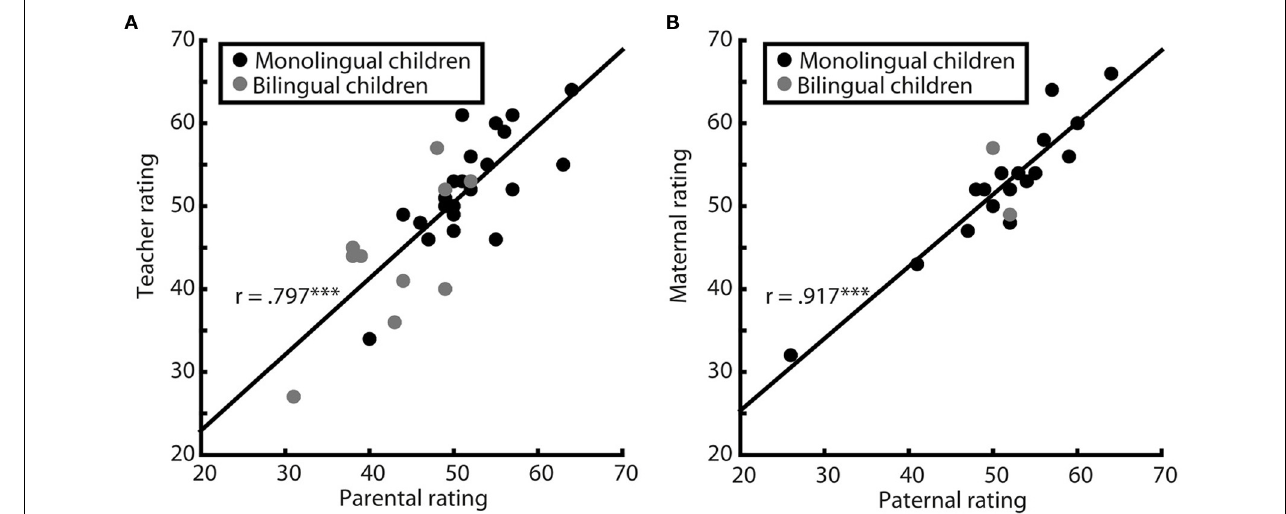
FIGURE 5 | Correlations of ratings. Pearson correlations of parent–teacher ratings ( A , n = 34) and of mother–father ratings ( B , n = 19), both significant (both p ≤ 0 . 001) and with large effect